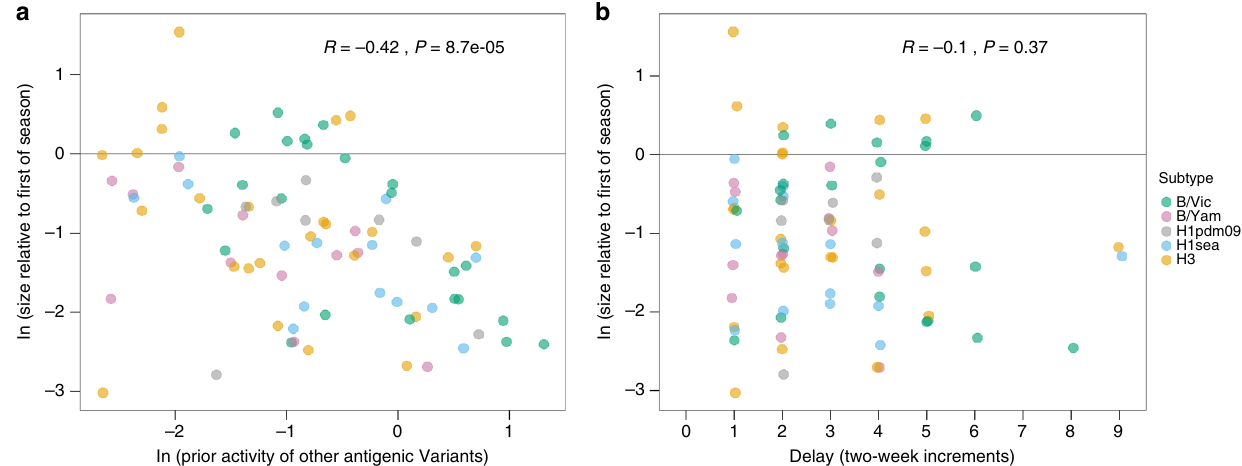
Fig. 5 Effect of competition among subtypes on epidemic incidence. The relationship between the size of an epidemic and a the amount of prior activity of all other antigenic variants and subtypes, and b the delay in epidemic onset. The size of each epidemic, relative to the earliest epidemic of that season, was log-transformed: the horizontal line at 0 denotes that the size of an epidemic is equal to that of the earliest epidemic of that season and city. In panel ( a ), prior activity by other subtypes within the same season was measured relative to the city-speci fi c mean epidemic size. In panel b , delay in epidemic onset was measured relative to the onset timing of the earliest epidemic of that season. r - and P values are from Pearson ’ s correlation tests ( n =